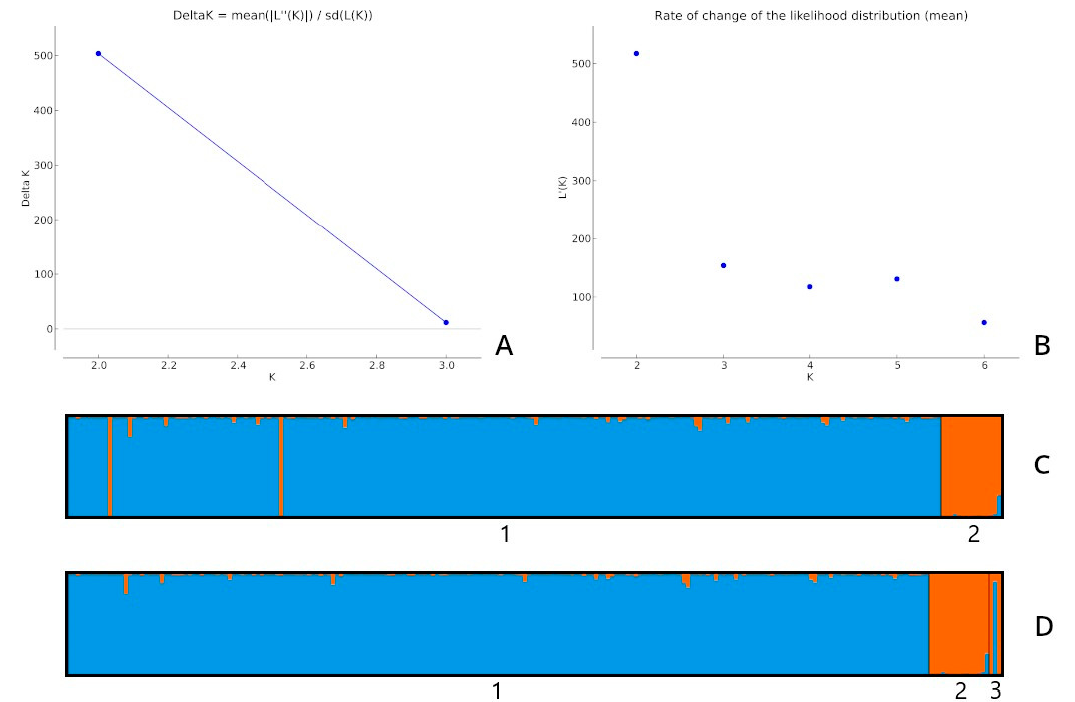
Figure 1. ( A ) Delta K values obtained with STRUCTURE HARVESTER for the second analysis (llamas and the rest of the individuals); ( B ) rate of change in the likelihood distribution (mean) for the third analysis (individuals divided into three populations: alpacas, llamas and putative hybrids); ( C ) structural analysis for K = 2 obtained for the second analysis; ( D ) structural analysis for K = 2 obtained for the third analysis. The number 3 indicates potential hybrids, 2 corresponds to the population of llamas, and 1 represents the remaining individuals.